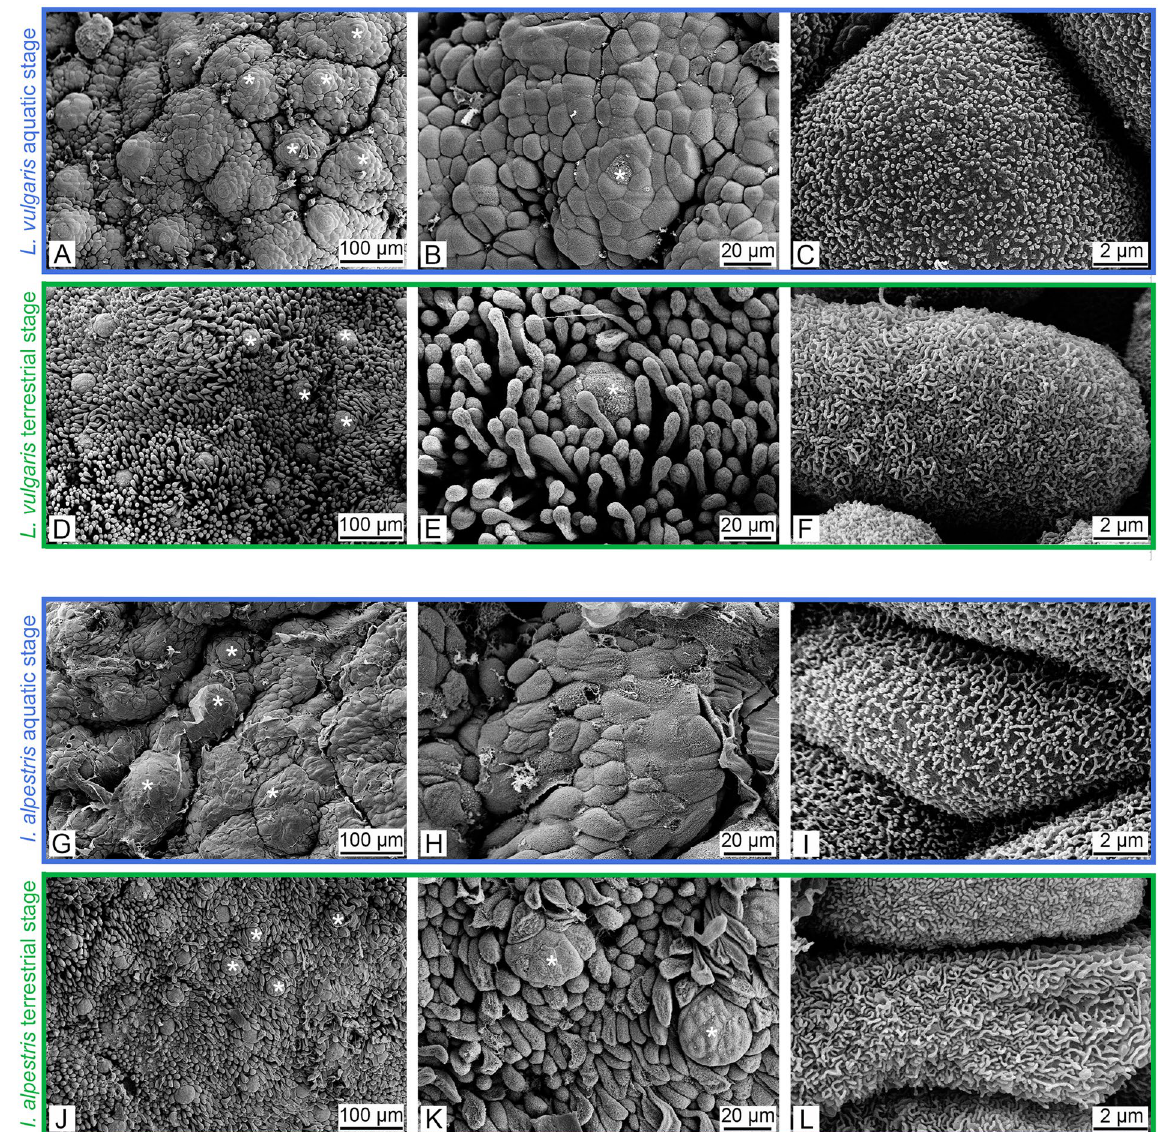
Figure 2. Scanning electron micrographs of the tongue pad surface in L . vulgaris ( A – F ) and I . alpestris ( G – L ) in the aquatic (blue frames) and terrestrial (green frames) stages. Images on the left are overviews and images in the middle and right are higher magnifications. Note the smooth tongue surface in the aquatic stage (( A , B) L . vulgaris and ( G , H ) I . alpestris ) and the presence of numerous surface-amplifying filiform papillae in the terrestrial stage of both species (( D , E ) L . vulgaris and ( J , K ) I . alpestris ). Taste-bud-bumps (indicated by asterisks) are free-standing in the aquatic stage but surrounded by the filiform papillae in the terrestrial stage. The epithelial cells in the aquatic stage bear microvilli ( C , I ), while the surfaces of the slender papillae in the terrestrial stage are covered by rough maze-like microplicae ( F , L